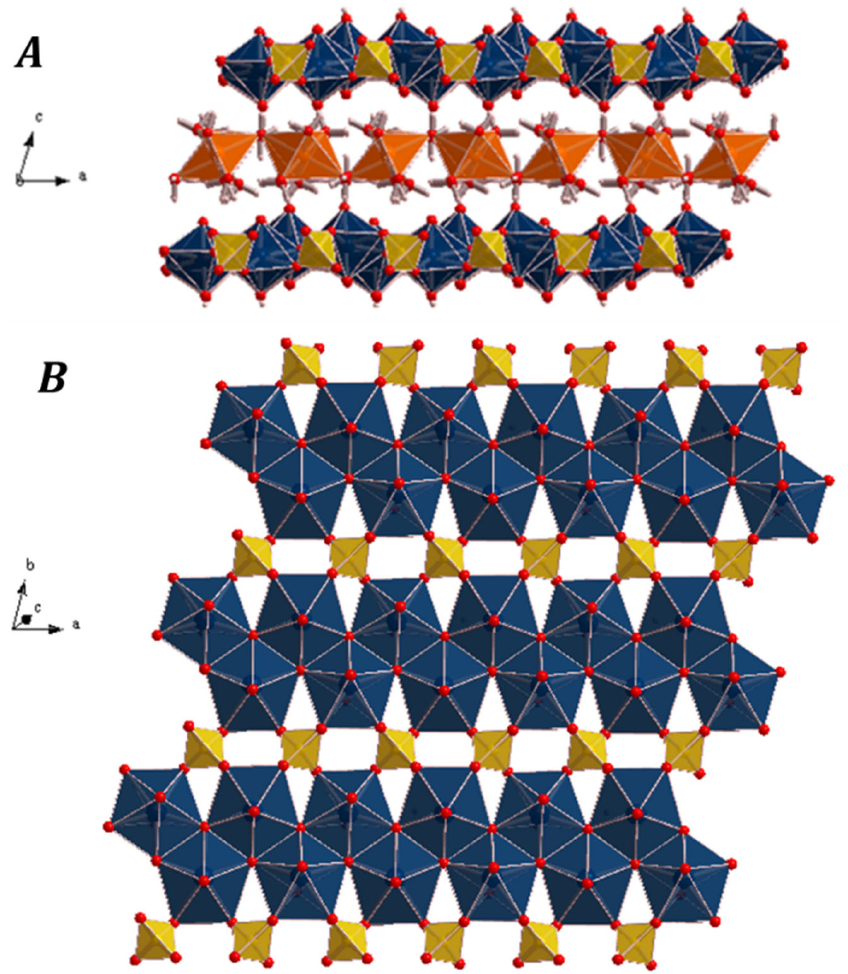
Figure 4. Views of the structure of pseudojohannite mineral: ( A ) view of the full unit cell from the [0 0 1] crystallographic direction; ( B ) view of a johannite uranyl sulfate sheet. Color code: Cu—orange; U—blue; S—yellow, O—red, H—white.